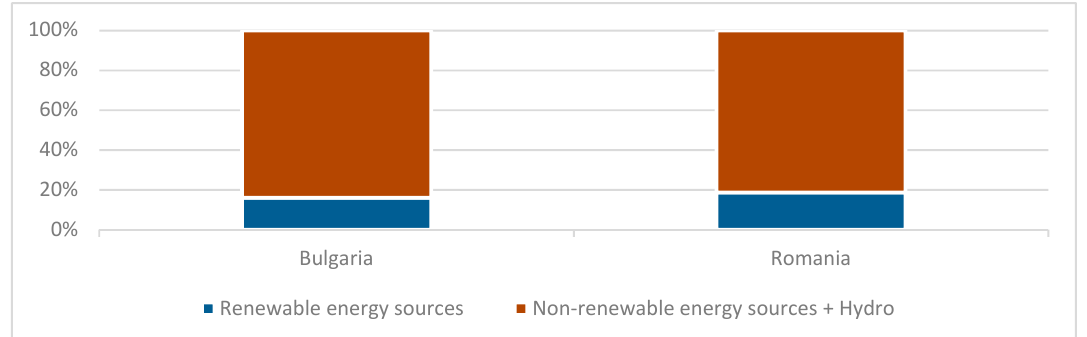
Figure 15. Energy sources in the countries of group C in 2016.